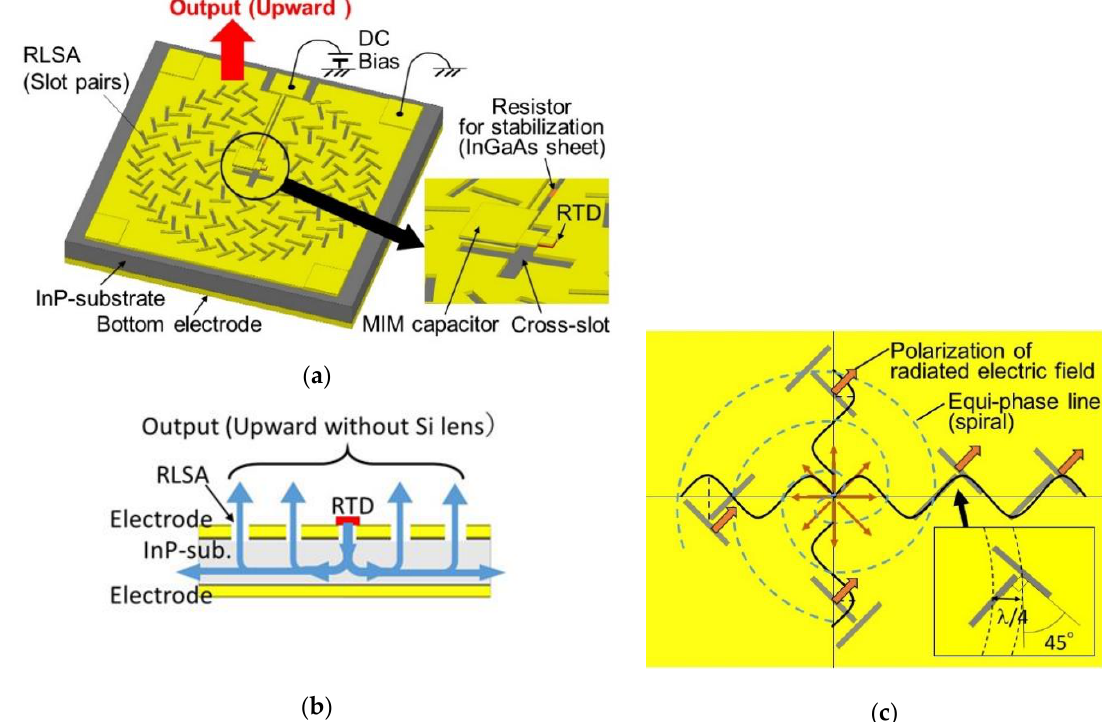
Figure 11. RTD oscillator integrated with radial line slot array (RLSA) for radiation of circularly polarized wave [64]: ( a ) Top view, ( b ) cross-sectional view, together with propagation of output from RTD, and ( c ) top view, together with phase distribution of the propagating wave in the substrate.